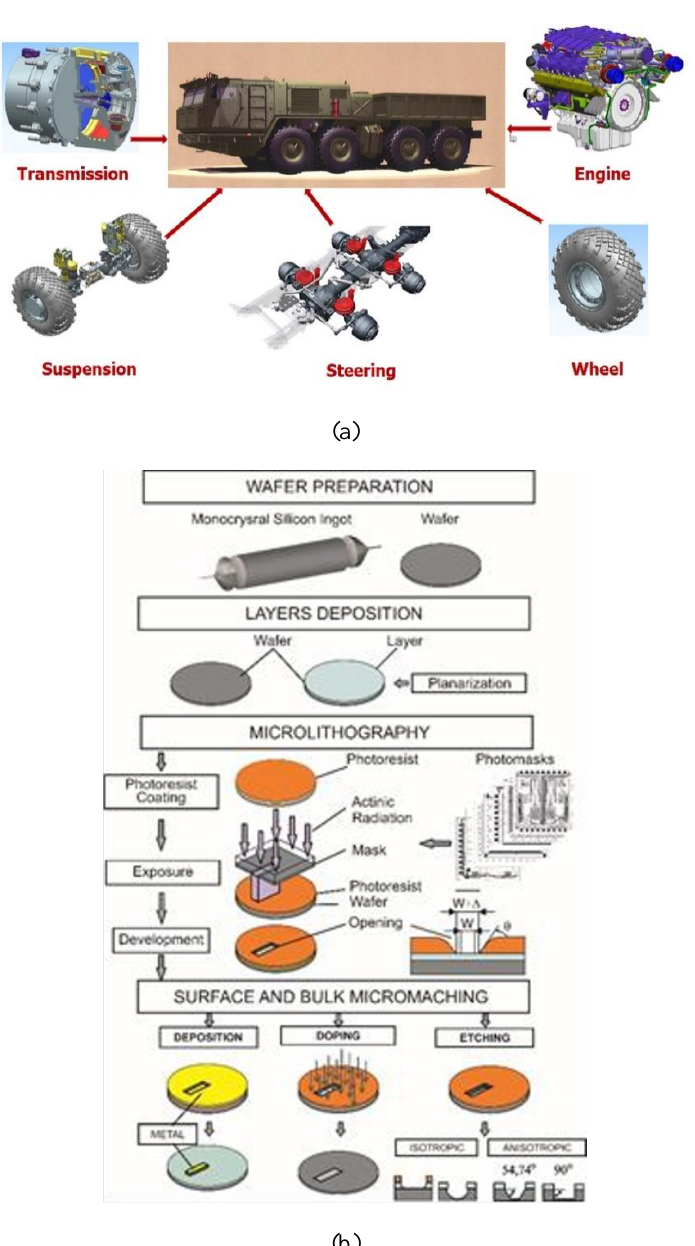
Fig. 4. The complex structure of technical systems: (a) special purpose vehicles, (b) microtechnology